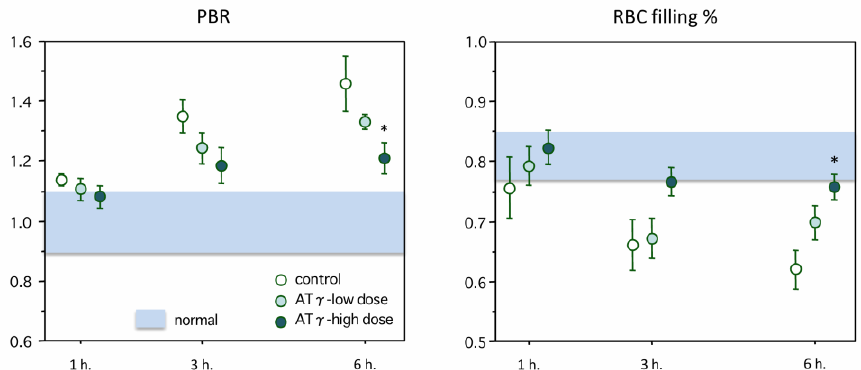
Figure 3. Changes in the perfused boundary region (PBR) and RBC filling percentage. Left: Table 1. 4-fold of the baseline value at 6 h after lipopolysaccharide administration. The increase in the PBR was significantly suppressed in the high-dose AT- γ group at 6 h ( n = 7 in each group). Right: The changes in the red blood cell (RBC) filling percentage in the mesenteric microvessels are shown. The RBC filling percentage started to decrease after lipopolysaccharide administration and reached 62% of the baseline value at 6 h. The RBC filling percentage was significantly maintained better in the high-dose AT- γ group at 6 h. * p < 0.05, compared with the control